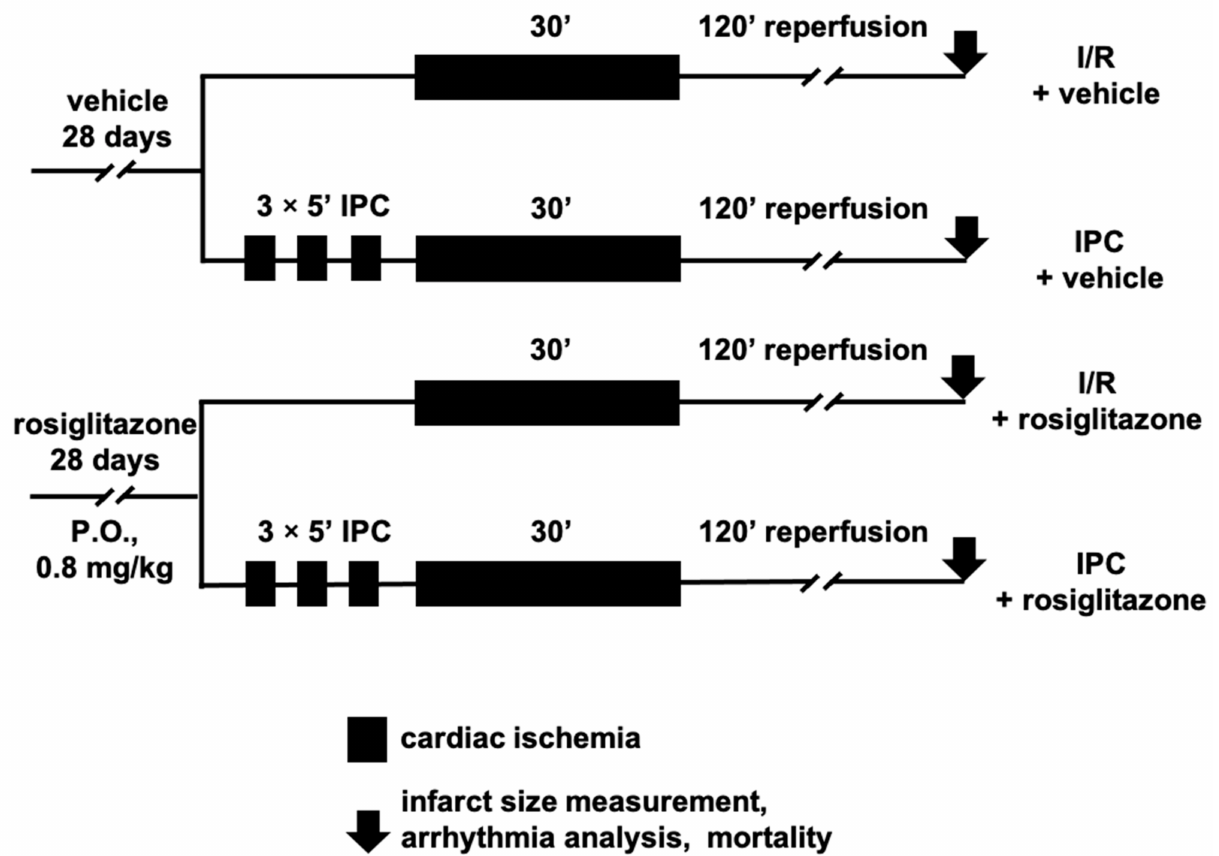
(I/R vehicle: 43.6 ± 4.7%; I/R rosiglitazone: 48.3 ± 2.3%; IPC vehicle: 37.7 ± 2.9%; IPC rosiglitazone 41.34 ± 2%).